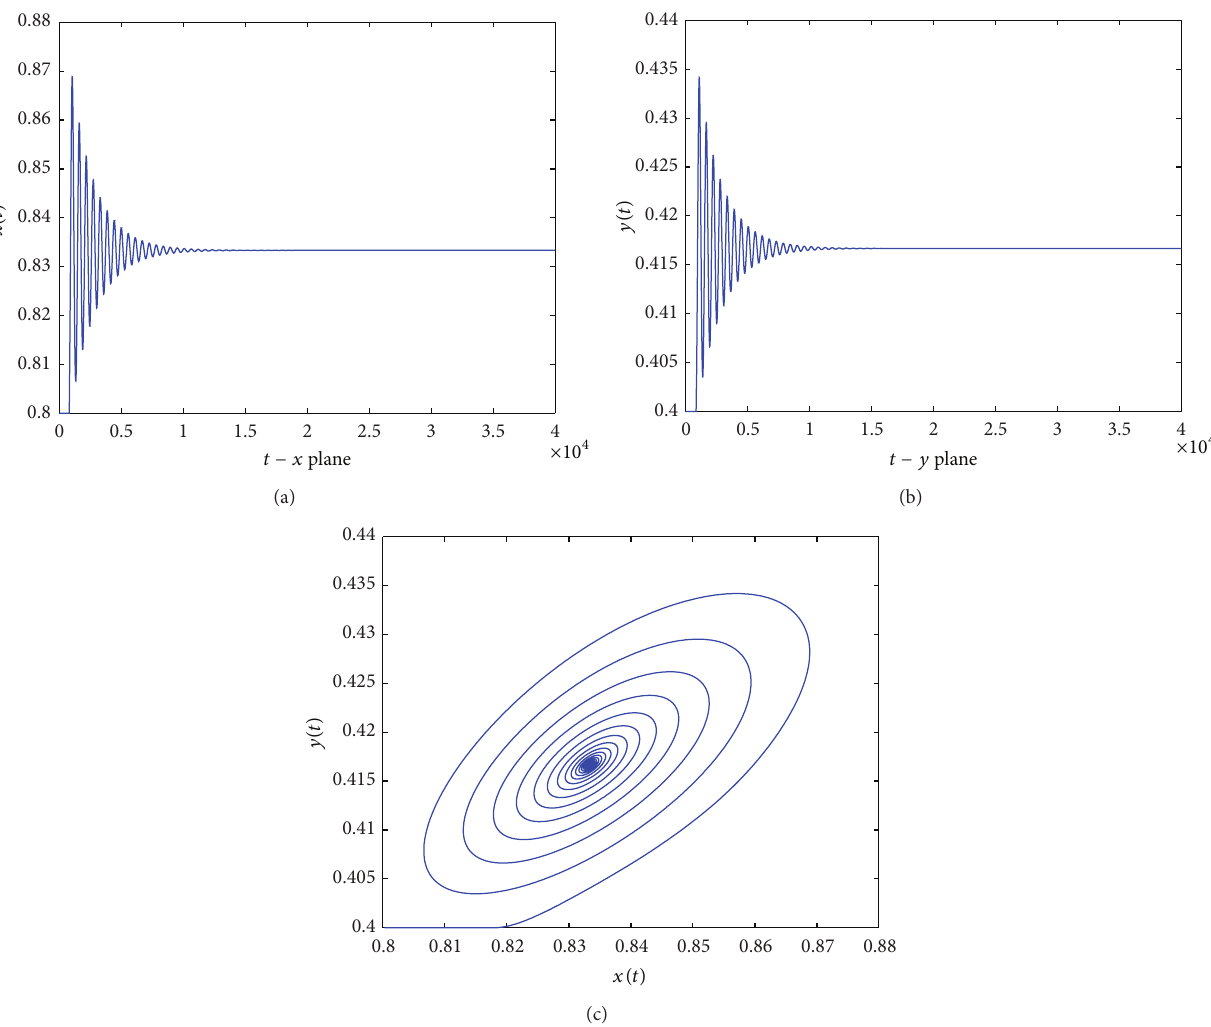
Figure 2: The trajectories and phase graphs of system (1) with 𝜏 = 𝜏 1 + 𝜏 2 = 6 + 4 = 10